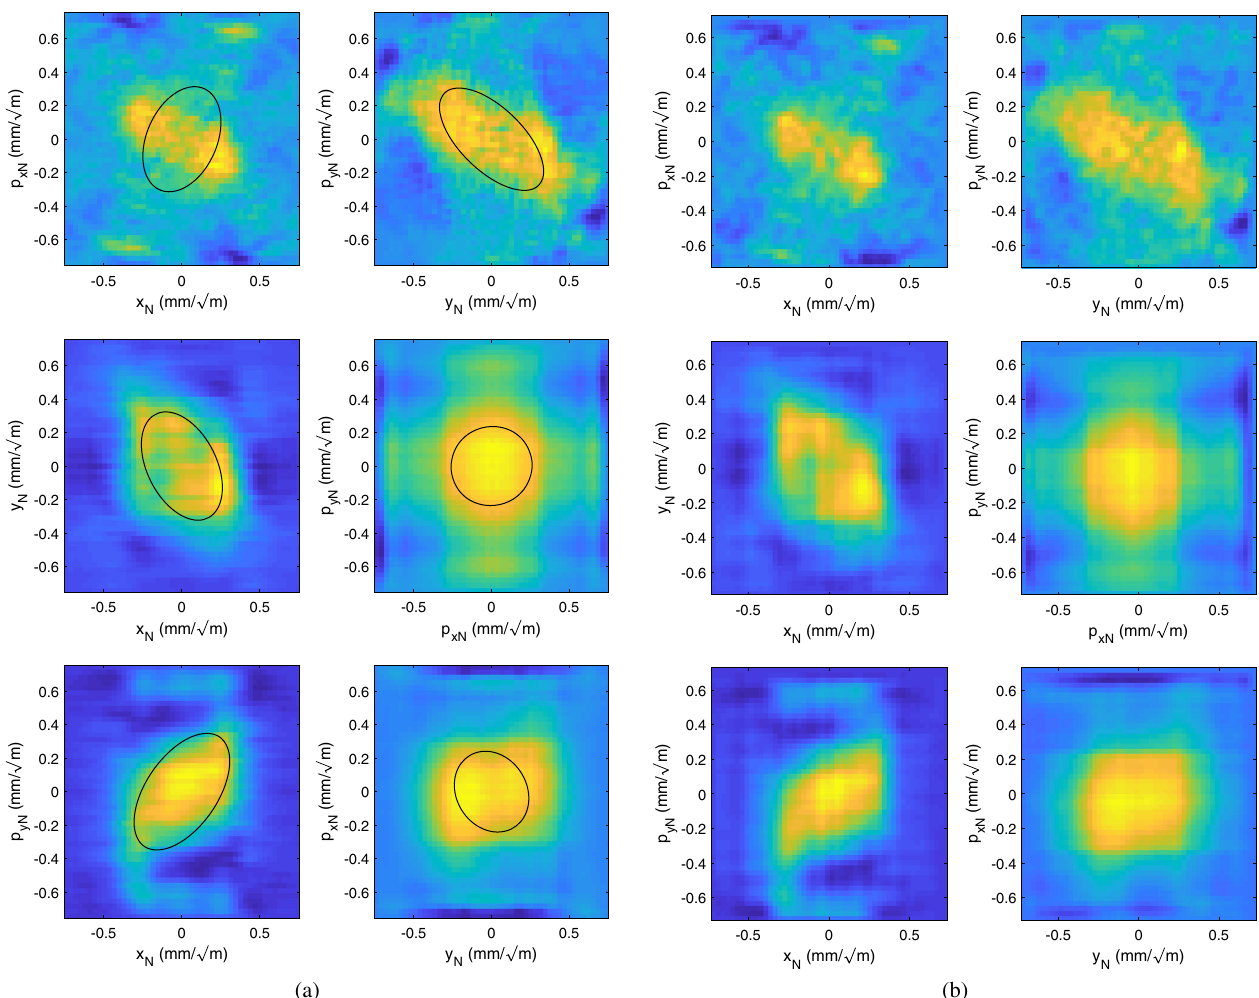
FIG. 7. Projections of beam density in normalized phase space, found from phase space tomography in two degrees of freedom in CLARA FE. Each plot shows a different projection of the charge density from four-dimensional phase space, using normalized phase space variables. The black ellipses show projections of the four-dimensional emittance ellipse obtained from a Gaussian fitted to the four-dimensional (normalized) phase space distribution. Coupling in the beam is evident in the tilt of the charge distribution in the cases that the axes refer to different degrees of freedom. The left-hand set of plots (a) shows the phase space distribution reconstructed from experimental data; the right-hand set of plots (b) shows the results of the tomography analysis applied to simulated data based on the measured phase space distribution, to validate the technique. Although there are some differences between the analysis results from the experimental data and the results from the simulated data, there is overall very good agreement in the phase space distribution found in each case, and in the emittances and optical functions corresponding to fitted emittance ellipses (see Table